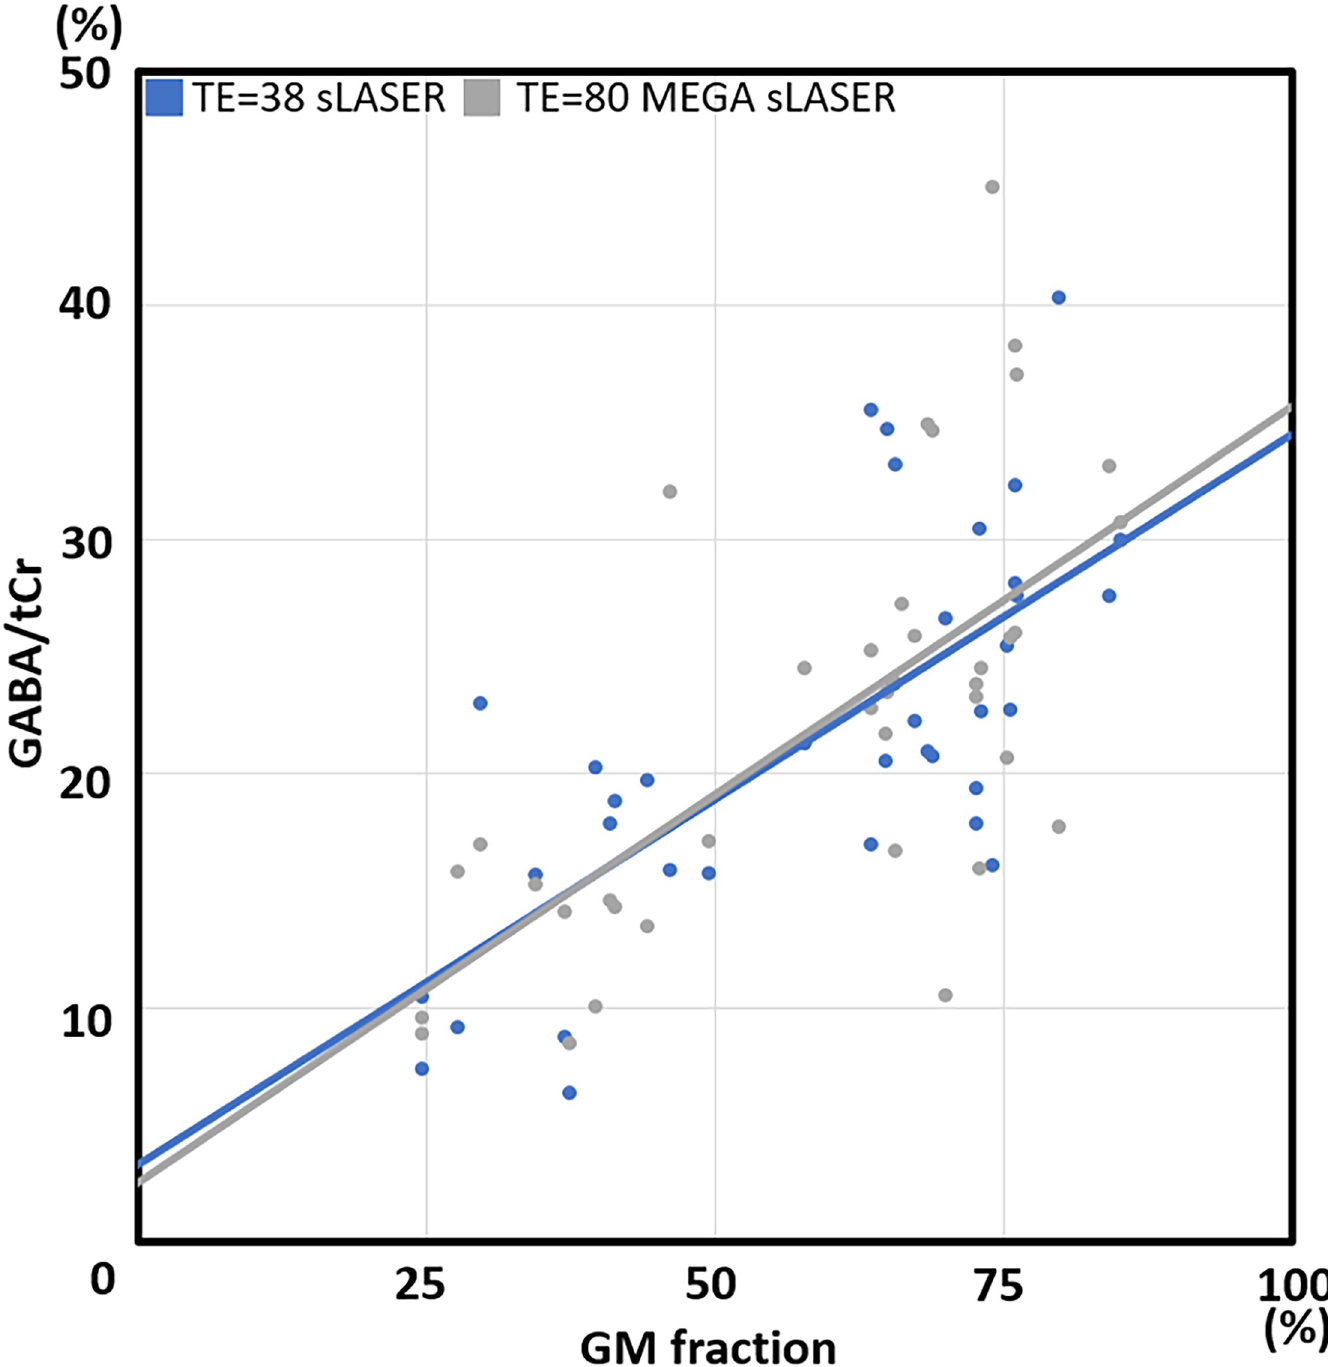
Fig 3. Correlation between GABA/total Cr(tCR) and gray matter (GM) volume fraction in the spectroscopy voxel. Spectroscopy signal was measured by two different approaches (blue: echo time (TE) = 38 semi-LASER (sLASER), gray: TE = 80 MEGA-sLASER) across all examined voxels after the T 2 correction. GABA concentration was in directly proportional to the GM tissue fraction. Linear regression lines of these two methods are almost identical. Equations of the linear regression lines were y = 29.27 x + 4.68 and y = 33.18 x + 2.54, unit (%). TE = 38 sLASER TE = 80 MEGA − sLASER